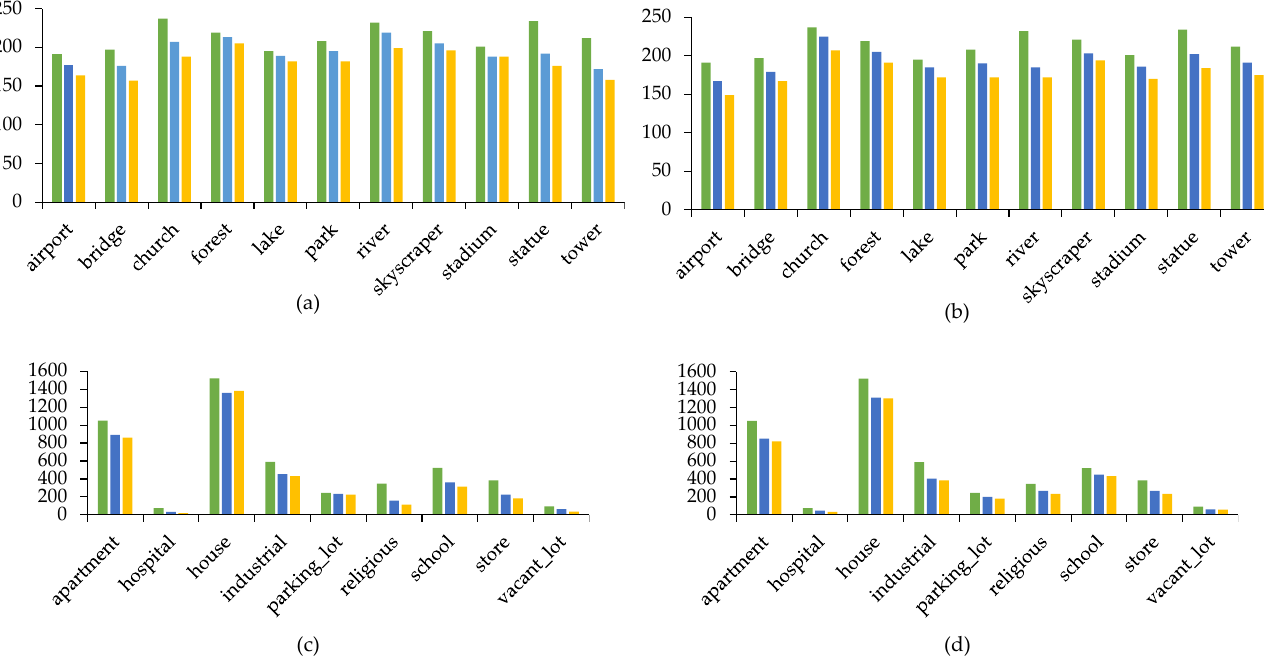
Figure 8. The number of credible samples in each class generated by experts’ votes and the TEB-SUQ using u ≤ 0.4 in the ( a ) aerial and ( b ) ground view of AiRound; ( c ) aerial and ( d ) ground view of